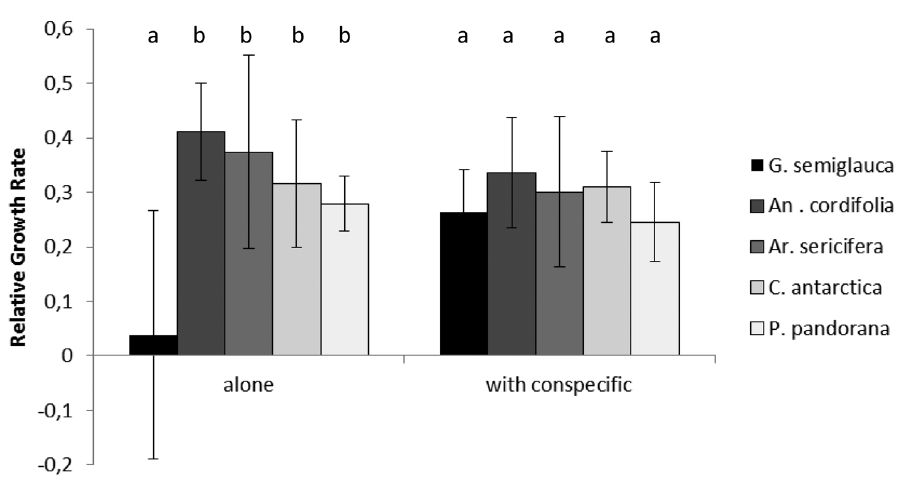
Figure 5. Average relative growth rate for seedlings of one rainforest tree and four species of lianas grown alone and with a conspecific. Letters above each group of bars are results from Tukeys multiple comparison tests where different letters represent significant differences within each set of